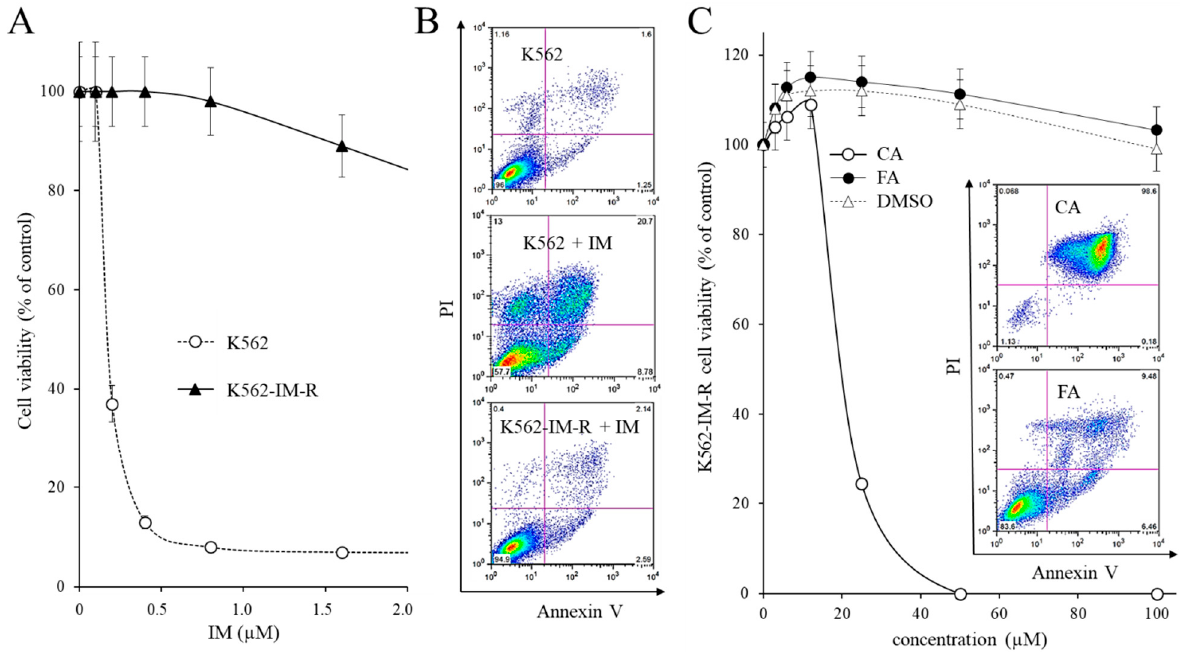
Figure 5. Effects of caffeic acid on viability and triggering apoptosis in IM-resistant K562. ( A ) Dose-dependent effects of IM on viability in sensitive (K562) and IM-resistant (K562-IM-R) cells three days after drug administration in the culture medium. ( B ) Representative flow-cytometer analysis of phosphatidylserine extroversion in sensitive K562 and K562-IM-R cells three days after the administration of 0.5 µ M IM for three days. Cells were stained with Annexin V/PI. ( C ) Effect of CA on the viability of K562-IM-R cells three days after the addition in the culture medium. All treatments were performed in the presence of 0.5 µ M IM in the culture medium. The results were expressed as arithmetic mean ± standard deviation. Insert: representative analysis of apoptosis carried out by staining with Annexin V/PI the cells treated in the presence of cytotoxic concentrations of CA or FA and 0.5 µ M IM. CA, caffeic acid; FA, ferulic acid; IM, Imatinib mesylate.